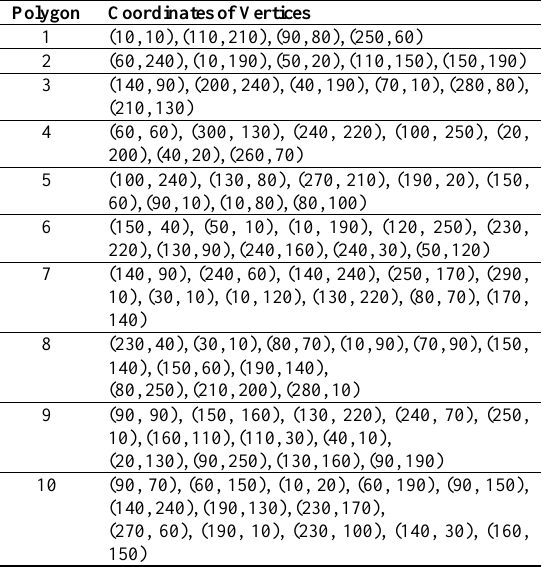
Table 1: The list of